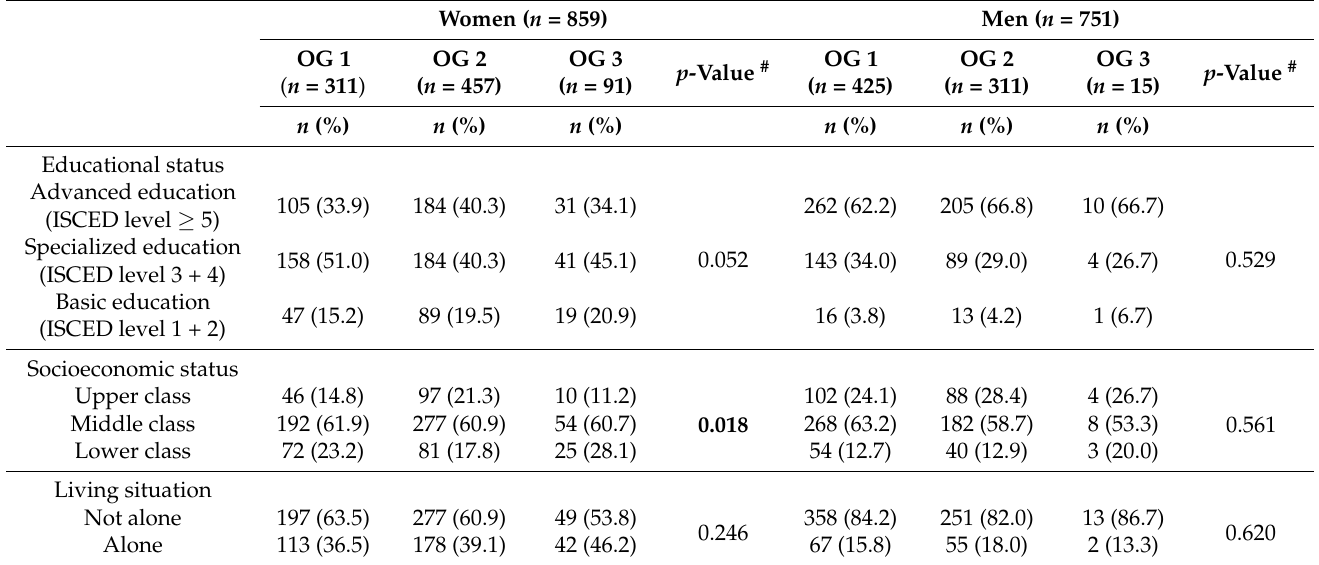
Table 3. Characteristics of the participants by sex and osteoporosis